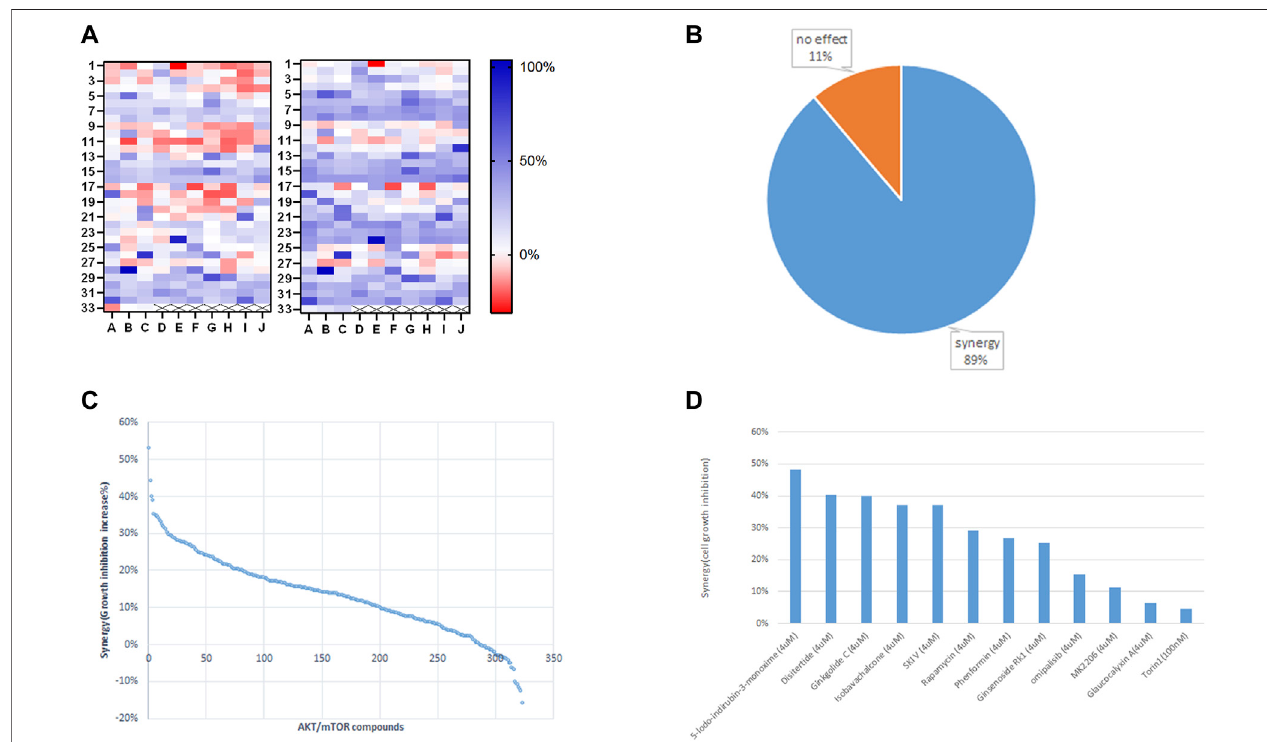
FIGURE4| SmalltargetedchemicalscreenusingthePI3K/Akt/mTORcompoundlibrary.4 (A) .TheheatmapanalysisofsynergybetweenST-539andAKT/mTOR inhibitorsonJurkatcellsgrowth inhibition. Jurkat Tcellsweretreatedwiththecompounds (4 uM)fromPI3K/Akt/mTORcompoundlibrary (322intotal) w/o10ug/mlST- 539 for 48 h, and the cell growth was analyzed by resazurin assay. The left one is the inhibition rate without ST-539, and the right one is the inhibition rate with ST-539. Data are the mean value from three biologically independent experiments. 4 (B) . The percentage of the compounds from PI3K/Akt/mTOR compound library synergize with ST-539 on Jurkat cells growth inhibition. 4 (C) . Ranks of synergistic effects between AKT/mTOR compounds and ST-539. Synergy is calculated by subtracting thegrowth inhibition causedbythecompound alone fromthegrowth inhibition caused bythecompound and ST-539 together.4 (D) . Thesynergybetween speci fi c compounds with ST-539. Data are the mean values from three biologically independent experiments.